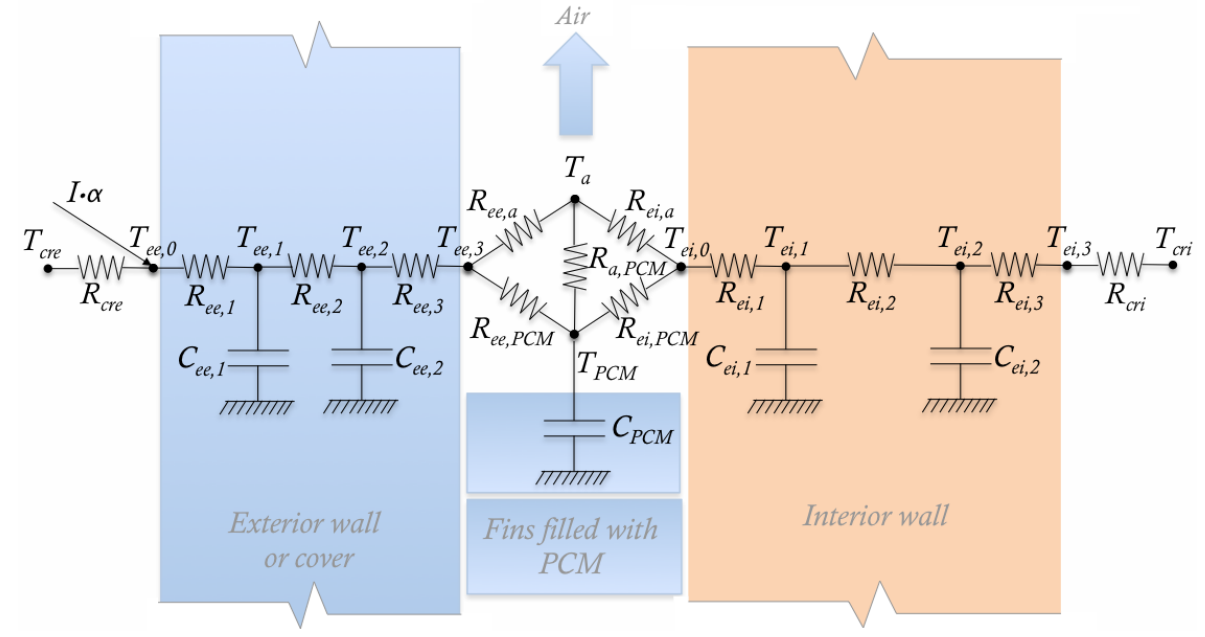
Figure 6. Simplified